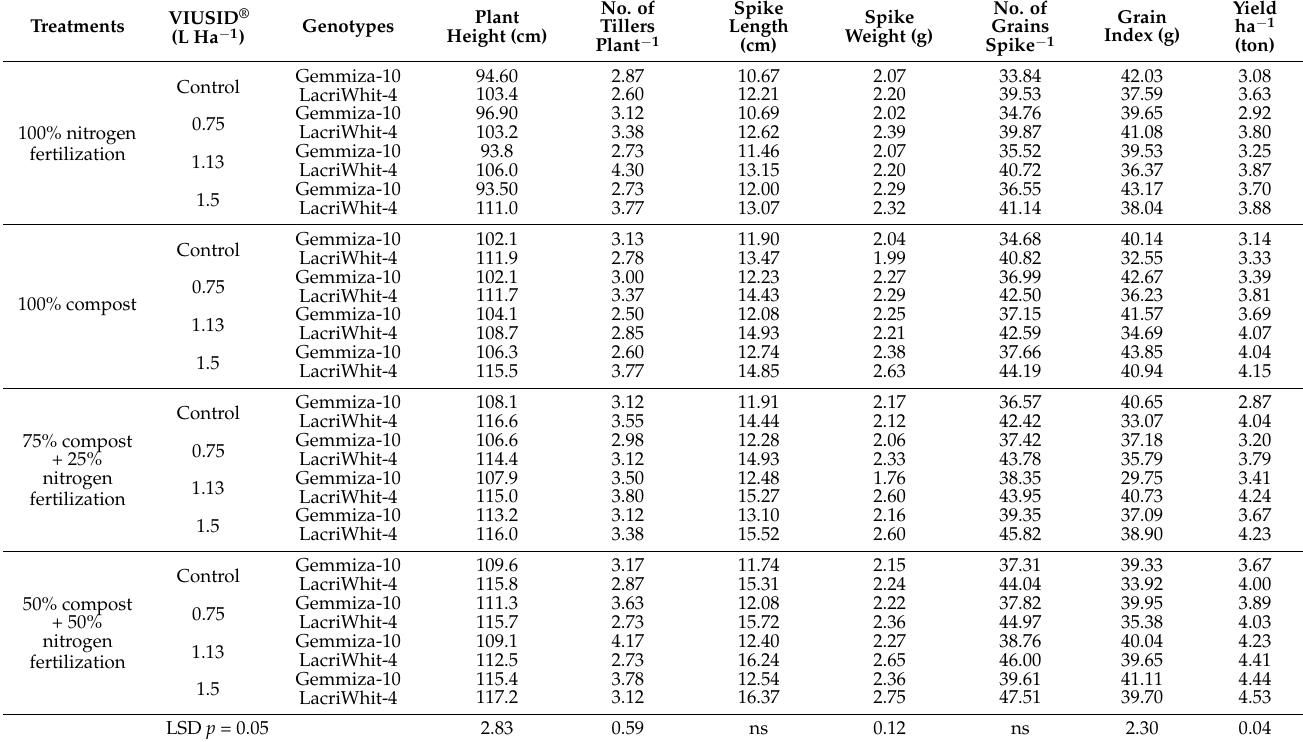
Table 6. Effect of different levels of compost and foliar application of VIUSID ® agro on agronomic characteristics of two wheat